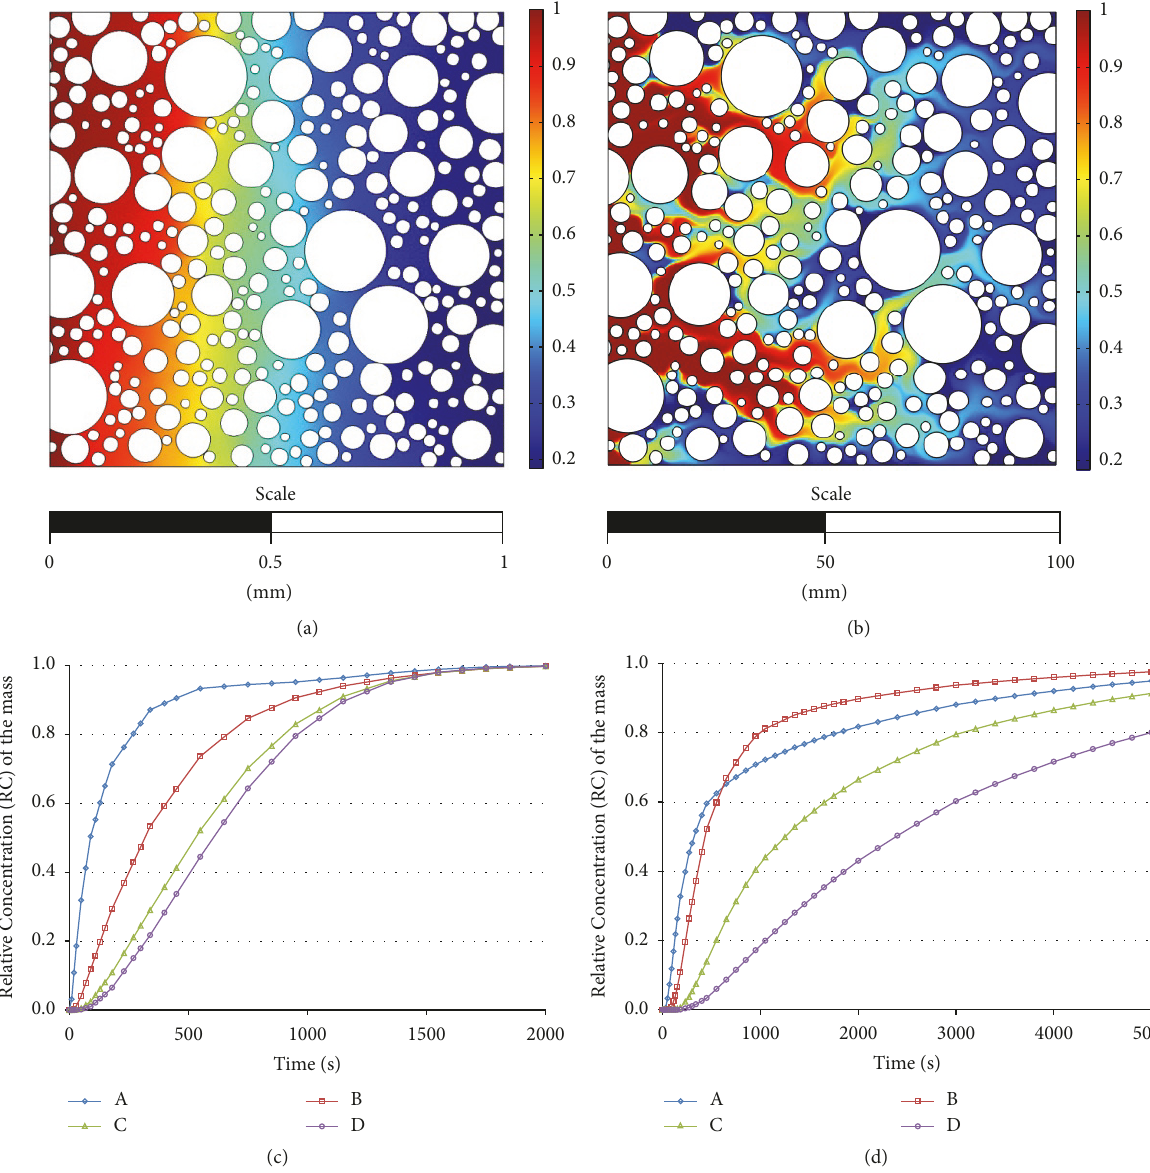
Figure 6: Relative Concentration (RC) of the tracer within each scale domain. For the model with the length scale of 1mm (a), it takes 306 seconds for the tracer to reach the Relative Concentration of 0.5 at the center line B, whereas, for the model with the length scales of 100mm (b), it takes 500 seconds. Evolution of the Relative Concentration (RC) over time at reference lines for models with the length scale of 1mm (c) and 100mm